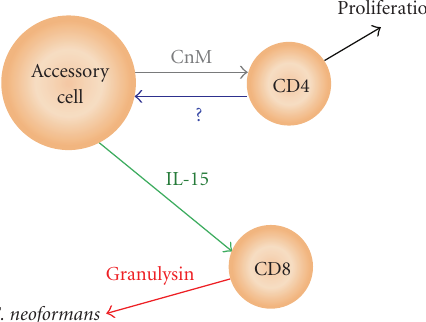
Figure 3: CD8 + T cells are primed for microbicidal activity following stimulation with C. neoformans mitogen (CnM). Recog- nition of CnM (presented by accessory cells) by CD4 + T cells triggers their activation and proliferation. Meanwhile, a reciprocal signal from CD4 + T cells mediated through an unknown receptor- ligand interaction (?) induces accessory cells to express IL-15, which in turn primes CD8 + T cells for granulysin expression and anticryptococcal